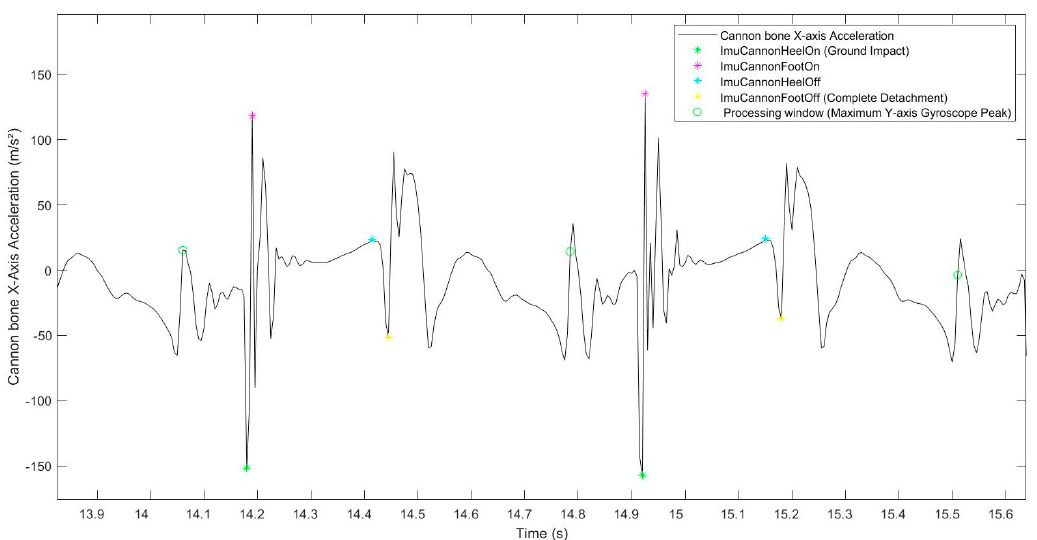
Figure 4. Representation of the cannon bone x -axis acceleration signal used to detect the foot-on (magenta points) and heel-off (cyan points) events.